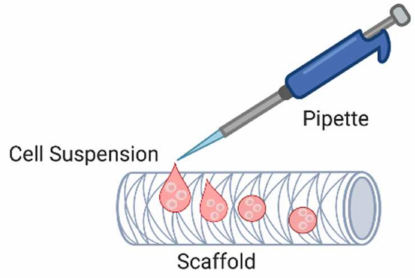
Figure 5. Passive seeding. Cell suspension is pipetted directly onto the lumen or exterior of the scaffold. (Created with BioRender.com, accessed on 8 January 2022).